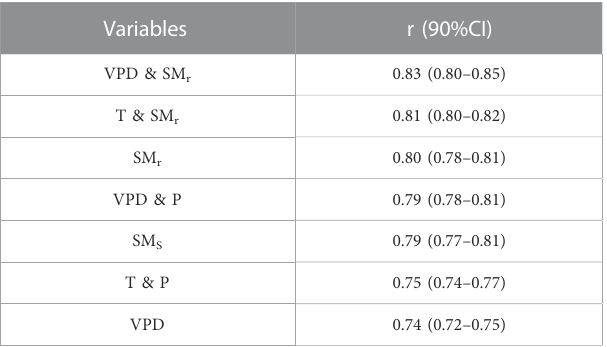
TABLE 1 Correlation between the estimated and actual yield anomalies. The correlation (r) between estimated and actual yield anomalies and the 90% con fi dence interval for the corresponding correlation (from n = 10,000 bootstrap realizations). The variables in the table are vapor pressure de fi cit (VPD), root-zone soil moisture (SM r ), maximum temperature (T), precipitation (P), and surface soil moisture (SM s ), all of which are daily